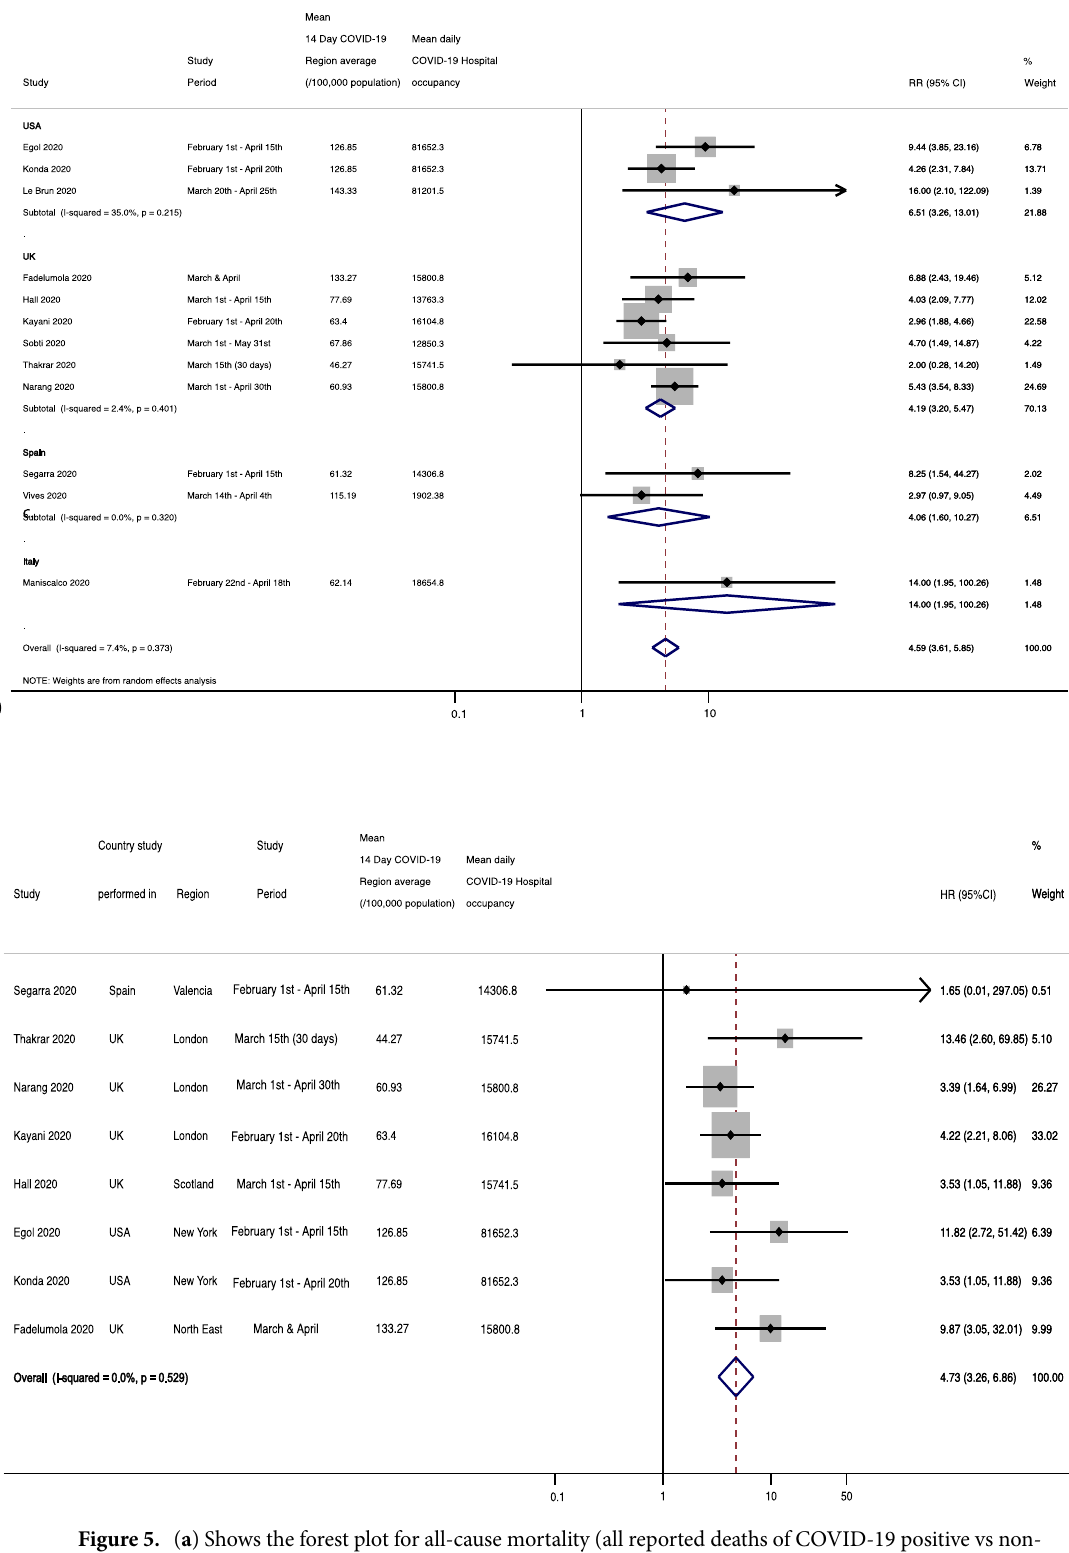
Figure 5. ( a ) Shows the forest plot for all-cause mortality (all reported deaths of COVID-19 positive vs non- positive COVID-19 patients). ( b ) Shows the forest plot for 30-day mortality for COVID-19 positive vs non- positive COVID-19